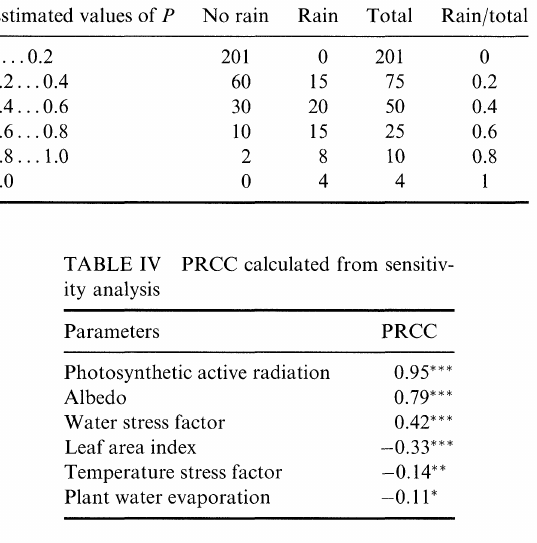
TABLE III Relationship between the estimated P values using 5 days interval simulation rainfall data and the mea- sured incidence of rain in Nazipur Estimated values of P No rain Rain Total Rain/total 0...0.2